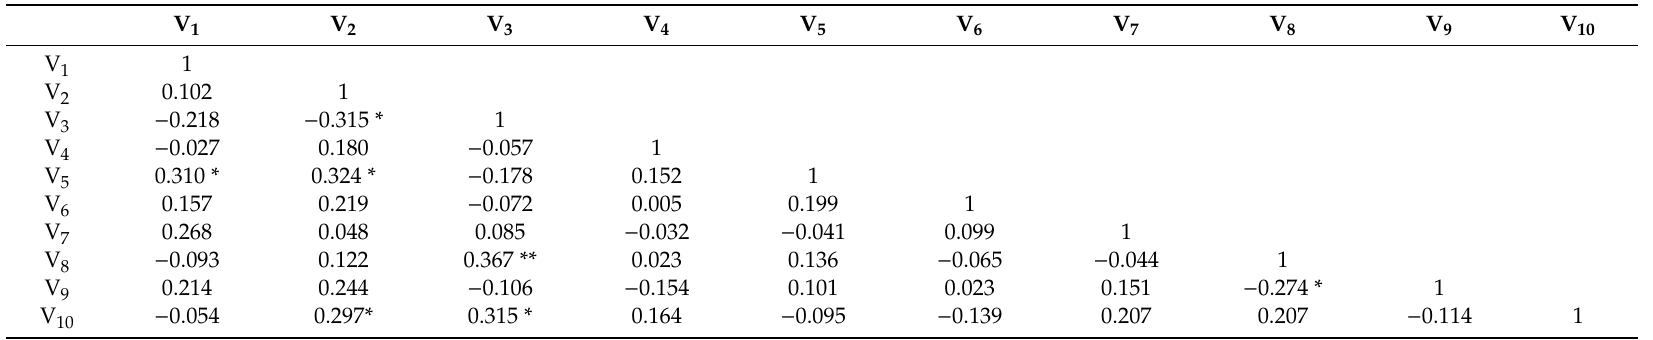
Table 2. Spearman correlations among